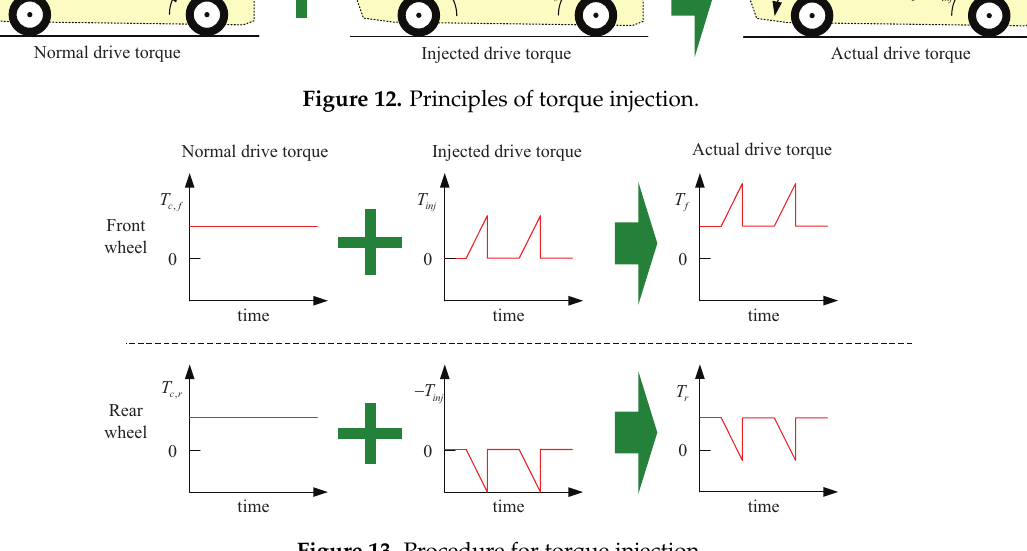
Figure 13. Procedure for torque